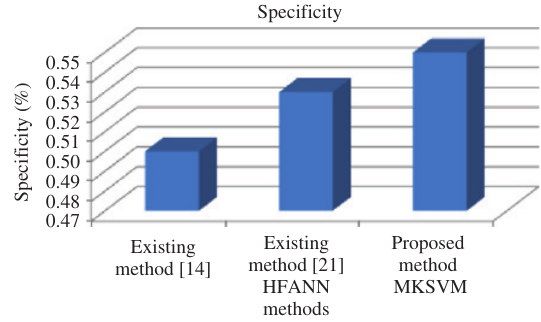
Figure 7: Comparative Analysis of